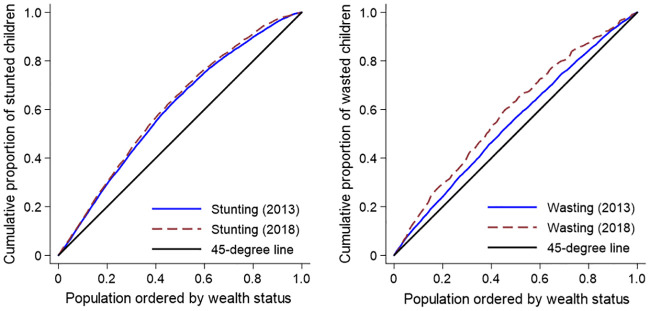
Concentration curves for stunting and wasting, Nigeria, 2013 & 2018.The concentration curves are not adjusted for Erreygers’ correction.